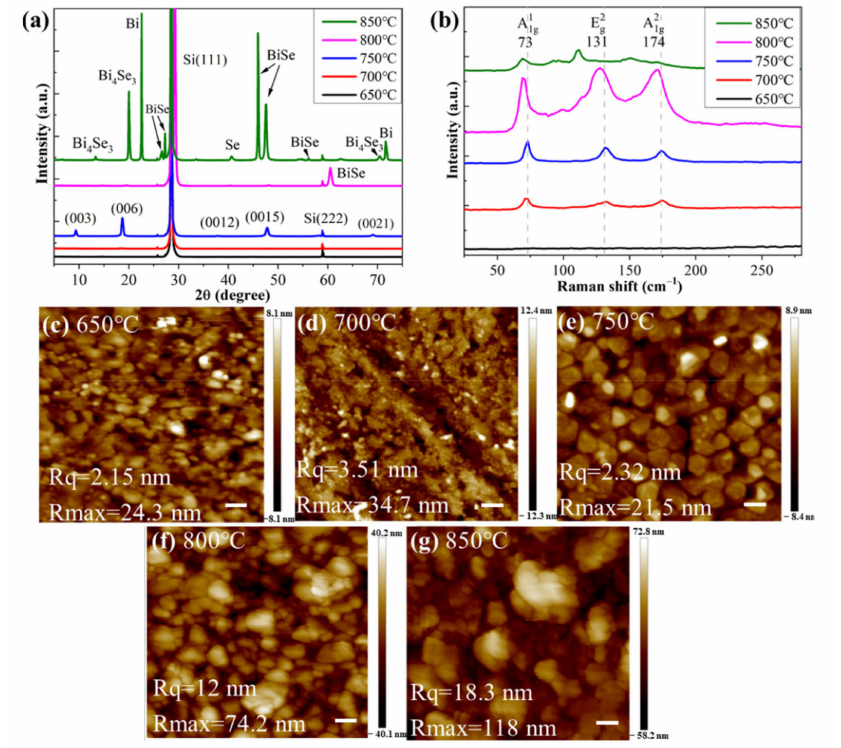
Figure 1. Characterization of Bi 2 Se 3 films grown at different Bi cell temperatures (650~850 ◦ C) and at the same growth temperature of 320 ◦ C and Se source cell temperature of 209 ◦ C: ( a ) XRD; ( b ) Raman; ( c – g ) AFM of sample surface. Scale bars in ( c – g ) are all 100